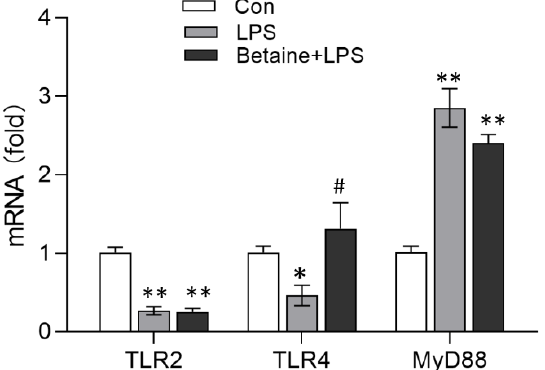
Figure 2. qRT-PCR quantification of the mRNA expression of TLR2, TLR4, and MyD88. The treatment and method were described in Figure 1 caption. Values are mean ± SEM, n = 6/group. Significance levels: * p < 0.05, ** p < 0.01 vs. control, # p < 0.05 vs. LPS.